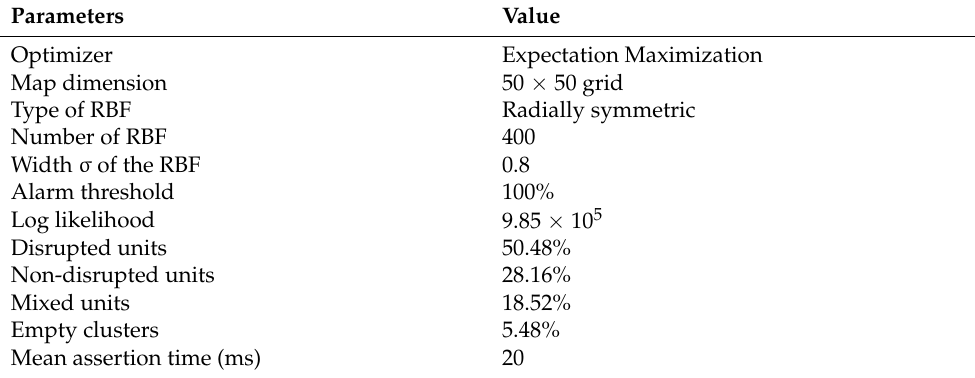
Table 5. GTM training